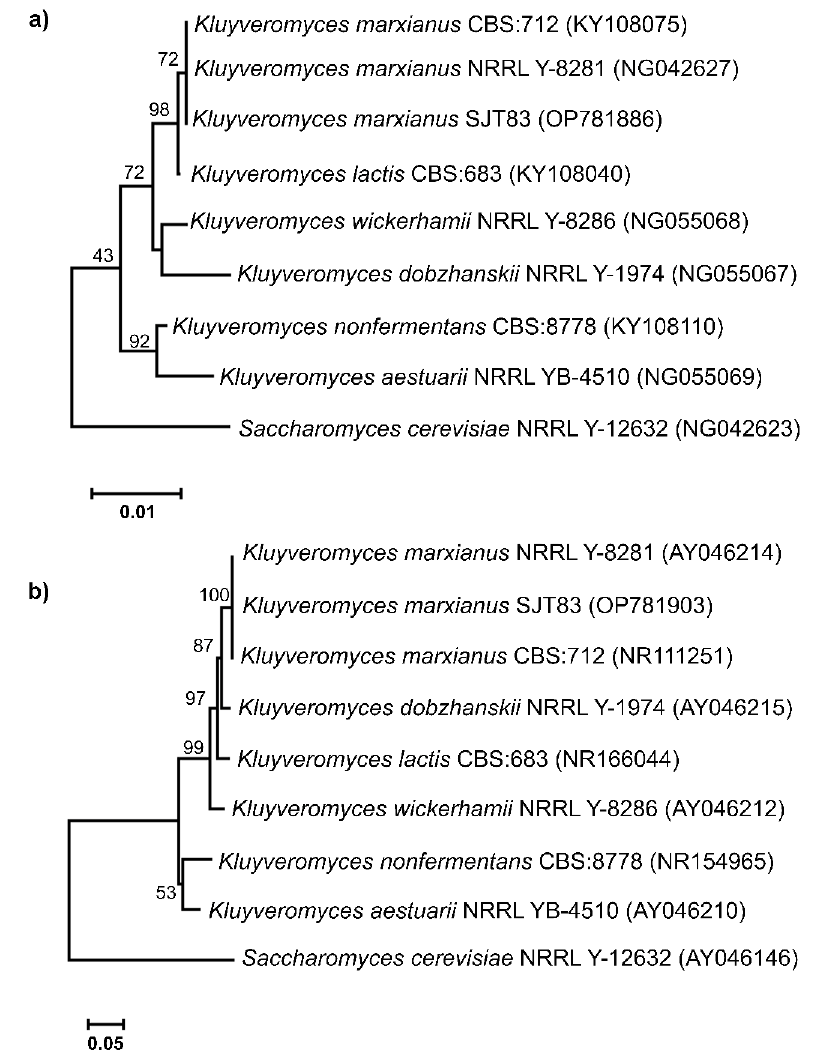
Figure 2. Time course of ethanol production and sugar assimilation ( a ) and cell growth ( b ) of yeast isolate SJT83 (filled symbol) and S. cerevisiae ND48 (open symbol) in sugar cane model medium, with total sugar (triangle), ethanol (square) and cell density (circle).